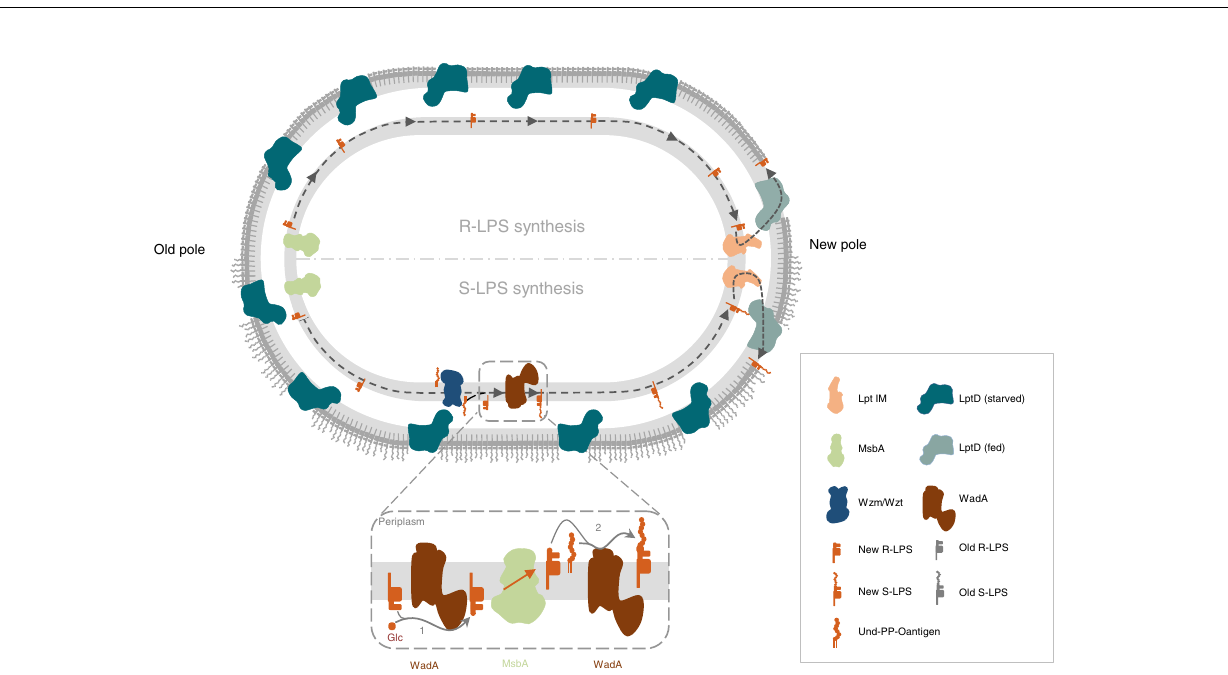
Fig.8|WadAlocalization. Representativepicturefor mNG-wadA and wadA-mNG inastrainco-expressingPdhs-mCherry,observedinexponentialphaseofgrowth.Both strains were observed in biological triplicates. The scale bar represents 2 µ m. Source data are provided as a Source Data fi le.